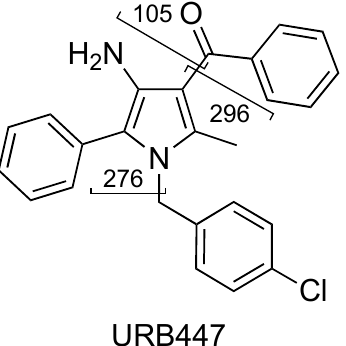
Figure 17 . Representation of alkali metal peaks of URB447 compound. Exponential scale to base 10. The fragment ions observed for URB447 are due to the cleavages of the carbon–carbon bond between the carbonyl and 3-pyrrolyl groups resulting in a benzoyl ion at m/z 105 or a 4-amino-1-[(4-chlorophenyl)methyl]-2-methyl-5-phenyl-1 H -pyrrol-3-ylium ion at m/z 296 (Figures 18 and 19, CE 35 V).